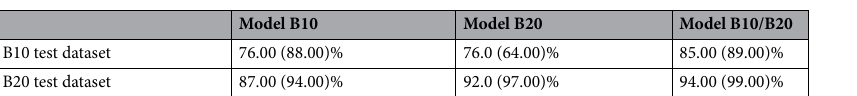
Table 3. MAP values calculated from the test dataset of own or other datasets, in order to verify the effect of magnification of the image on model performance. The values in parentheses are masked mAP which represents the accuracy of the mask region as predicted by the model compared to the ground truth